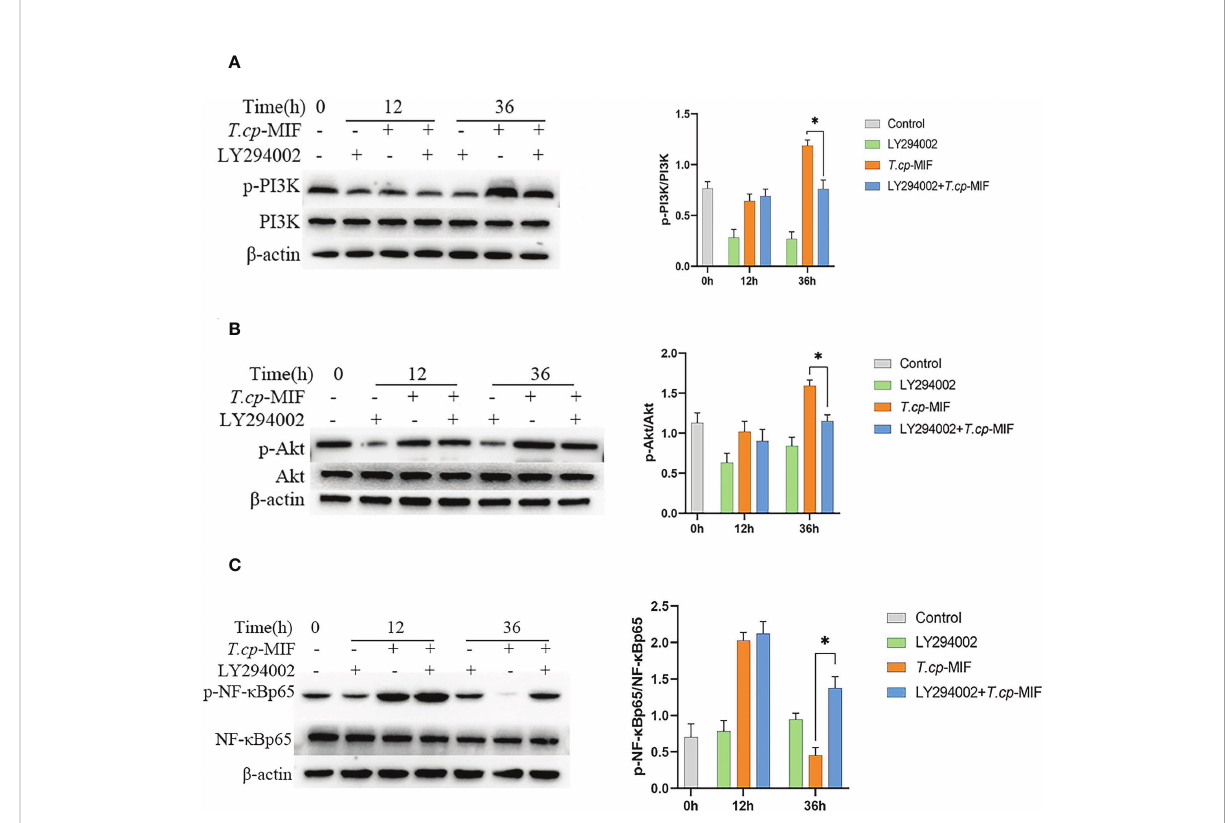
FIGURE 10 The effect of LY294002 on the expression of macrophage polarization-related proteins. (A – C) The cells were pretreated with LY294002 (the PI3K inhibitor) for 12 h, and the expression levels of PI3K, p-PI3K, Akt, p-Akt, NF- k Bp65 and p-NF- k Bp65 were detected by western blot. * indicated P <0.05. Results are showed as the mean of three times of independent experiments ( x ̄ ±SD, n=3).